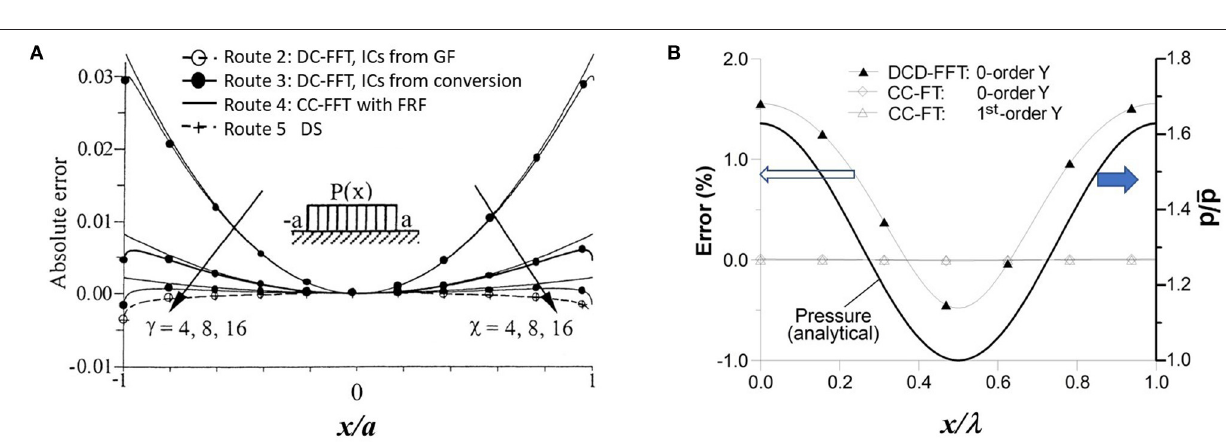
regions of special concerns, such as edges, interfaces,